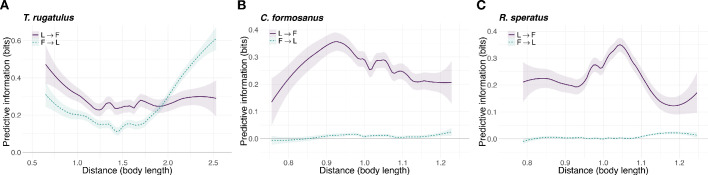
Predictive information over distance between runners.Average local transfer entropy as a function of the distance between centroids of runners for the compound pausing and rotation pattern (smoothed conditional means with LOESS smoothing and 0.3 span). (A) T. rugatulus, (B) C. formosanus, and (C) R. speratus.